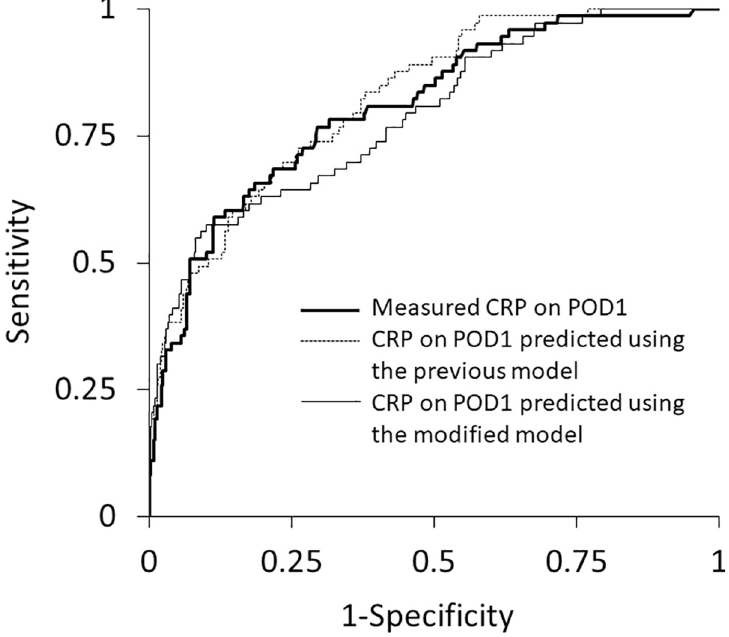
Fig 2. Receiver operating characteristic curve analysis between predicted and measured CRP levels on POD1 and postoperative major complications. Receiver operating characteristic curves for major complications (Clavien-Dindo grade IIIa or greater) versus measured CRP on POD1 (bold line), and predicted CRP on POD1 using the previous model (dotted line) and modified model (black line). CRP: C-reactive protein, POD: postoperative